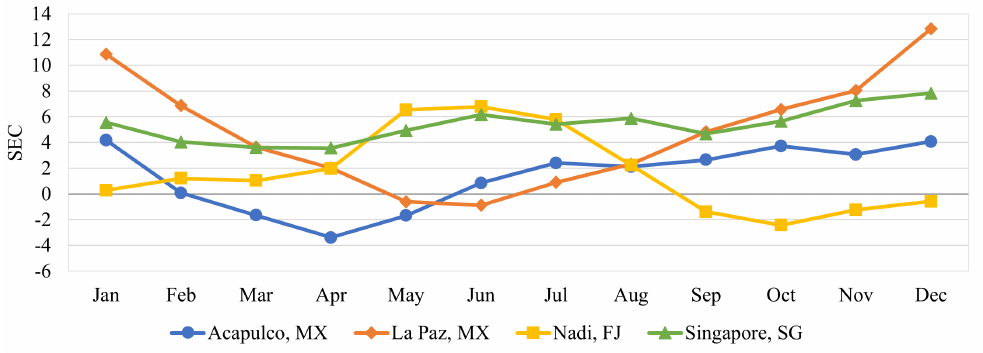
Figure 8. Monthly SEC of CPVT-VMD system under different weather